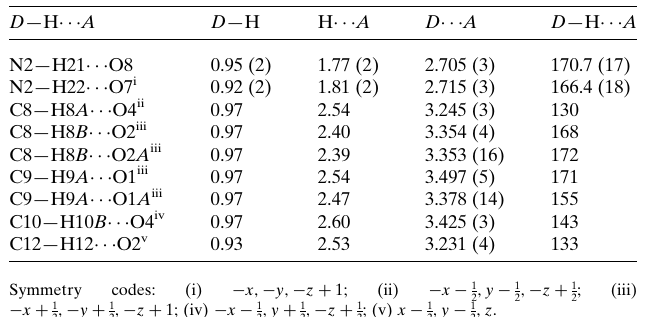
Table 3 Hydrogen-bond geometry (A˚ , (cid:4) ) for 3 .